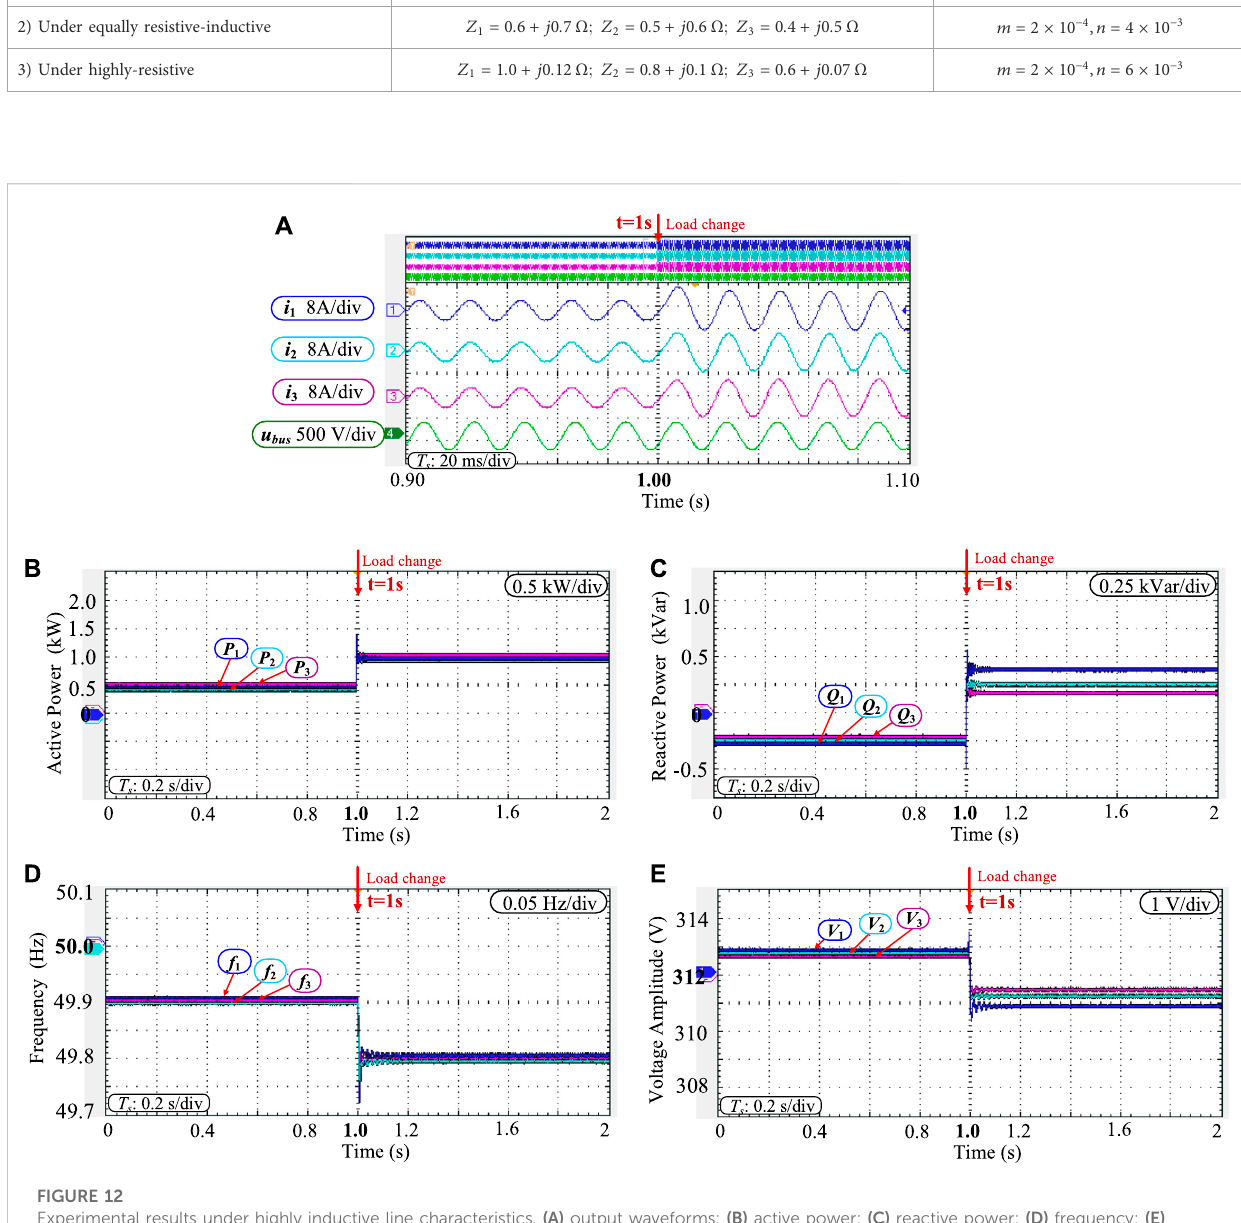
FIGURE 12 Experimental results under highly inductive line characteristics. (A) output waveforms; (B) active power; (C) reactive power; (D) frequency; (E) voltage ampltitude.